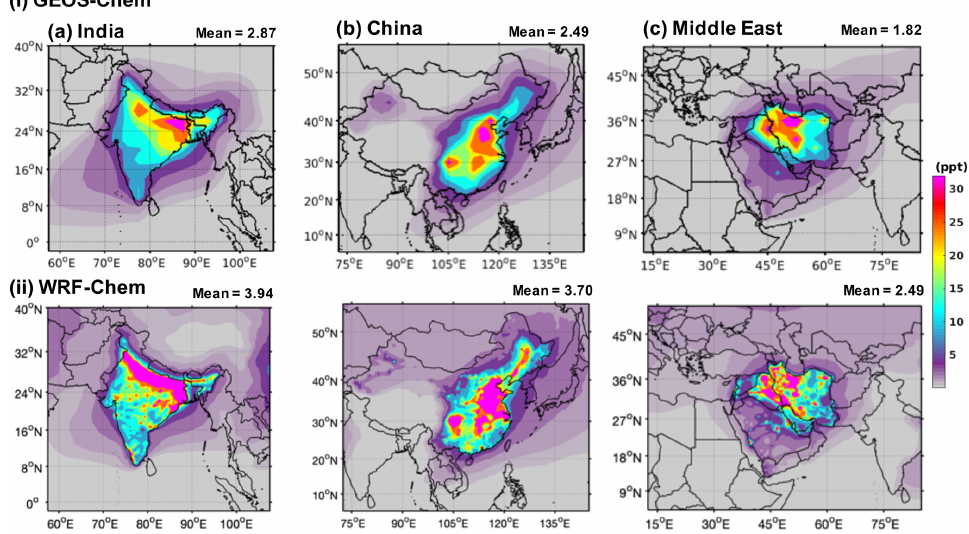
Figure 5. Annual mean surface mixing ratios of HFO-1234yf simulated in (i) GEOS-Chem and (ii) WRF-Chem over (a) India, (b) China, and (c) the Middle East. The number at the top of each panel gives the mean HFO-1234yf mixing ratios within the